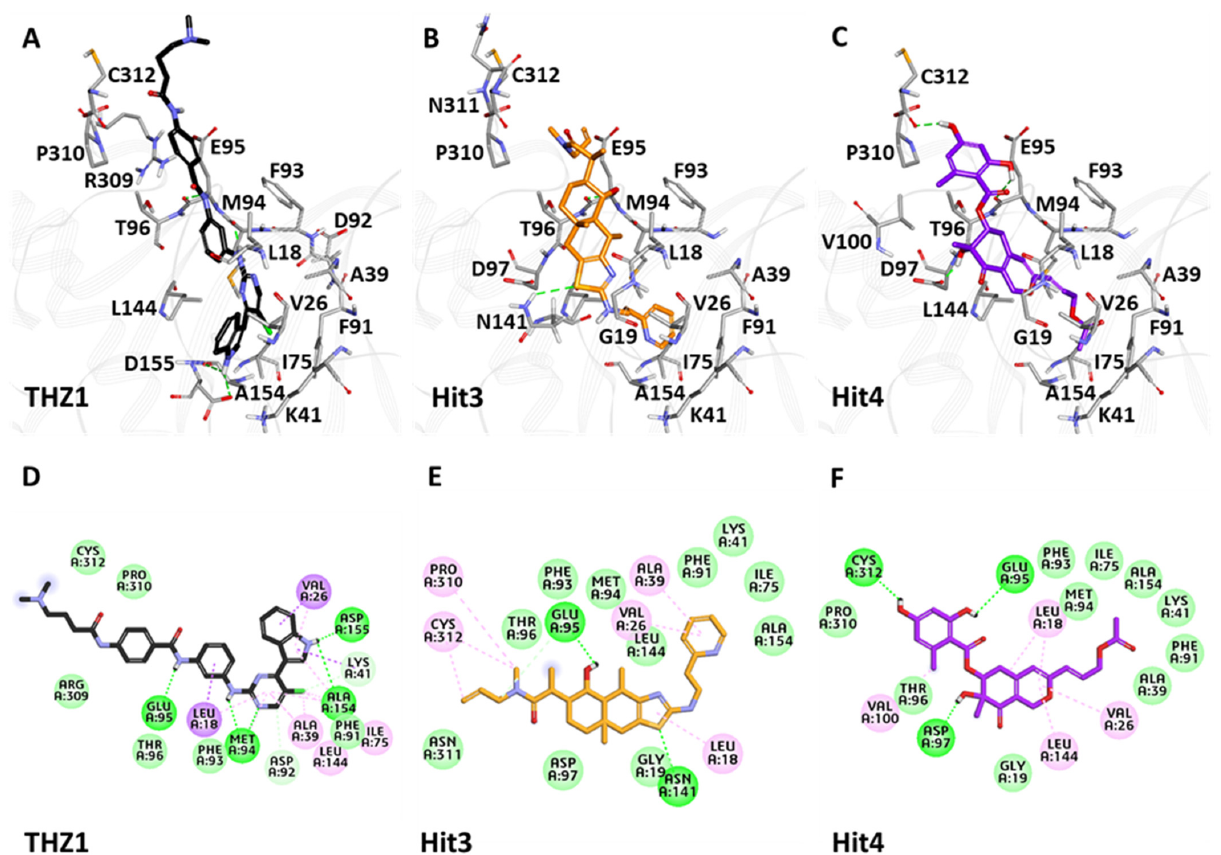
Figure 9. Binding mode and intermolecular interaction of THZ1 ( A , D ), Hit3 ( B , E ), and Hit4 ( C , F ) with CDK7. Upper and lower panel represents the interactions in 3D and 2D, respectively. The protein in the background is shown with grey lines, whereas interacting residues are shown as grey sticks. The dark green dashed lines indicating hydrogen bonds, light green: van der Waals, purple: π -sigma, while the π - π and π -alkyl interactions are shown in pink.